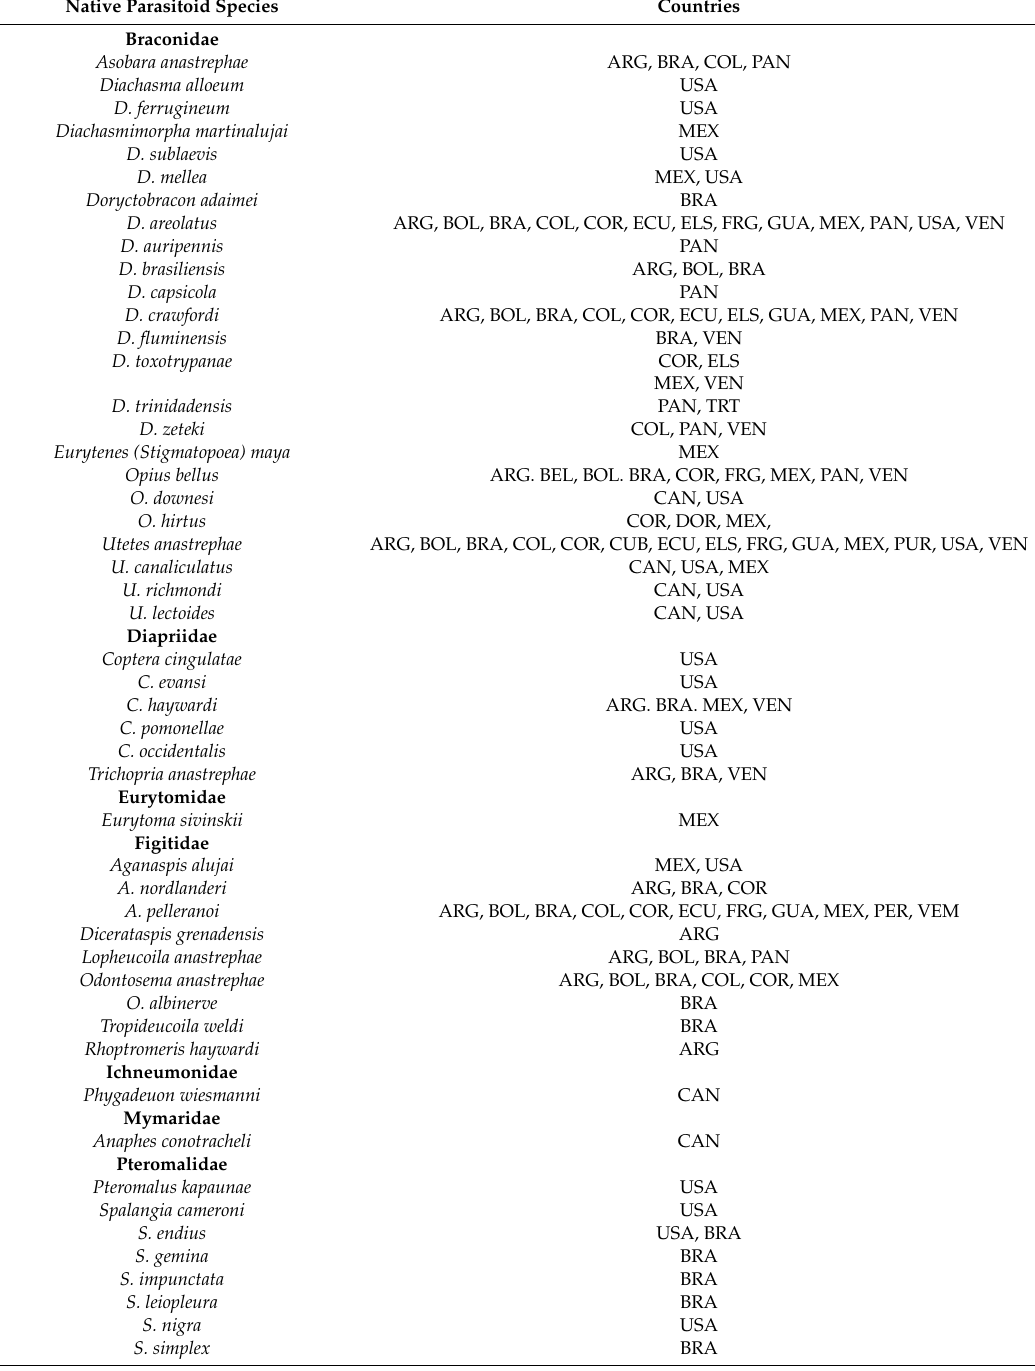
Table 3. List and distribution of native Hymenopteran parasitoid on fruit-infesting Tephritidae in the